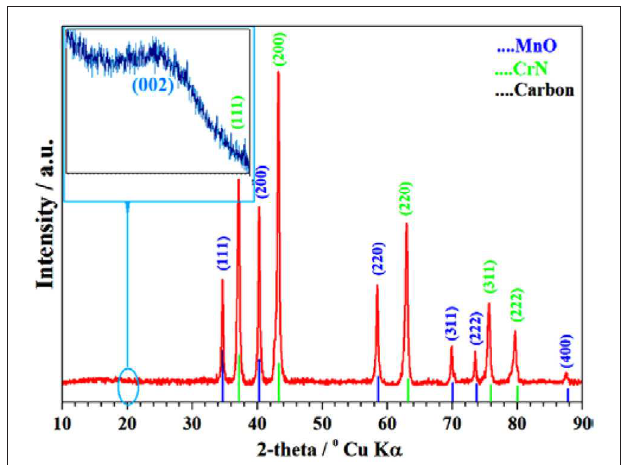
FIGURE 3 | XRD of Cr/rGO nanocomposite with MnO. XRD, X-ray powder diffraction; rGO, reduced graphene oxide.